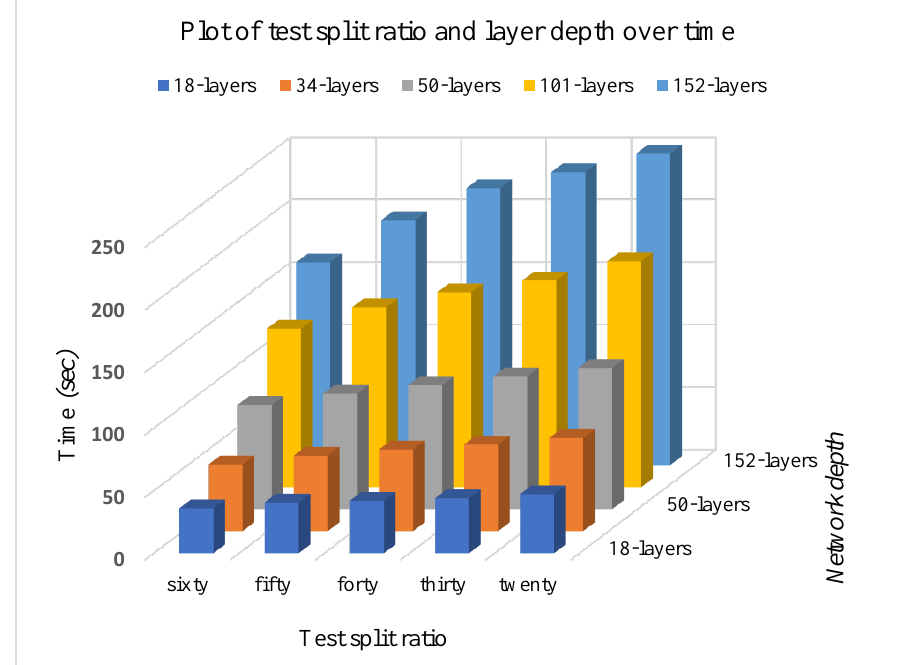
Figure 10. A plot of validation split ratio and layer depth over time.